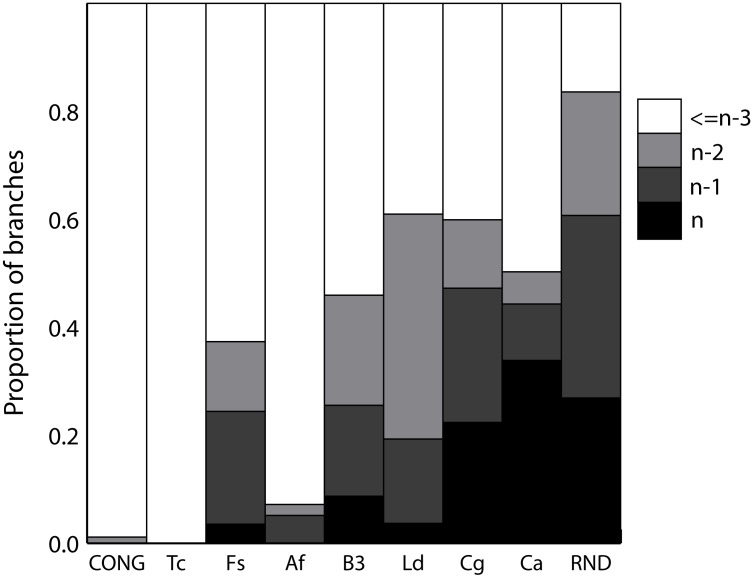
Topological incongruence distribution for standardized datasets.The color scale-bar represents the number of fragments topologically incompatible with certain branch. It varies from n incongruent fragments (black bars) to less than n-3 (white bars), where n is the number of fragments of the dataset. The values are calculated as the mean of 10 replications.